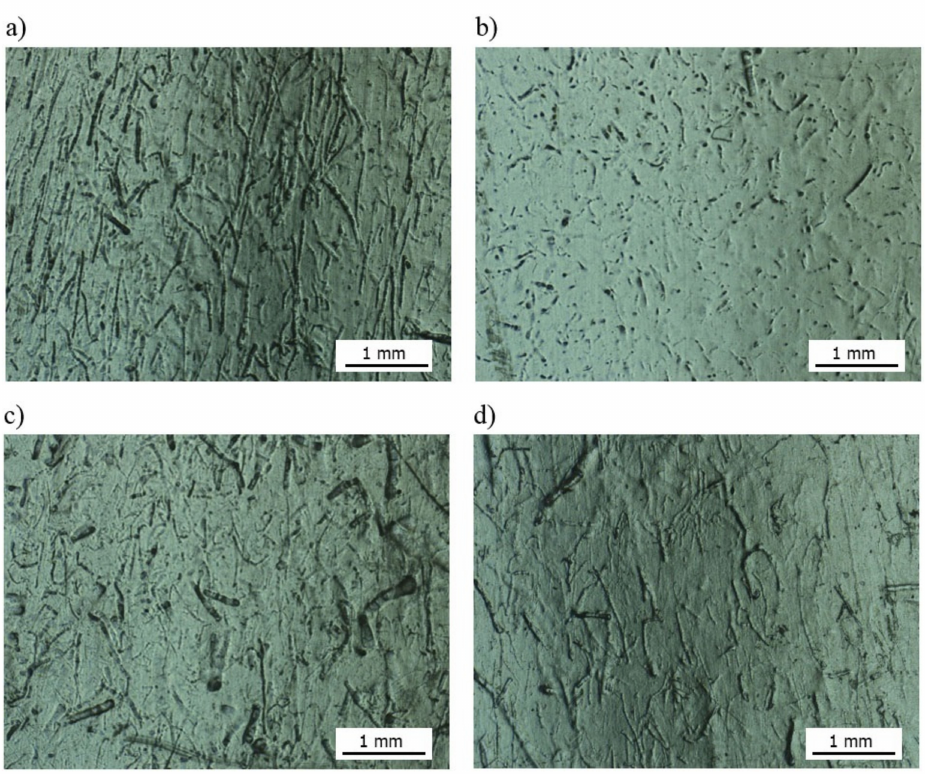
Figure 8. Areas of molded piece surface (50 × magnification) for biocomposites: ( a ) L0, ( b ) L10, ( c ) K0, ( d )